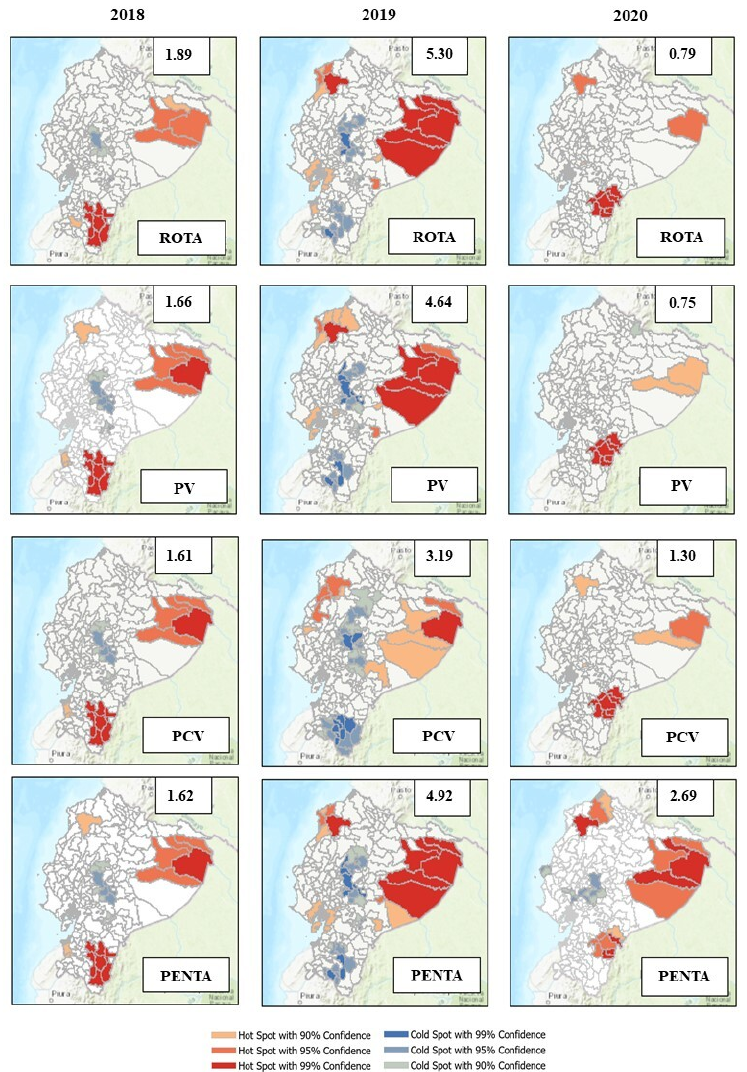
Figure 3. Spatial analysis of vaccination coverage rates for infants in 2018, 2019, and 2020 in Ecuador. The maps show patterns of high (red) and low (blue) vaccination coverage areas compared to their neighboring locations. Numbers in the superior square indicate the Global Moran’s I index, calculated using the coverage of the last dose of every vaccine applied. Cold spots in the 2020 maps indicate low vaccination coverage percentages for these three antigens in the Guayas province, with a 76.25% vaccination coverage. In the case of